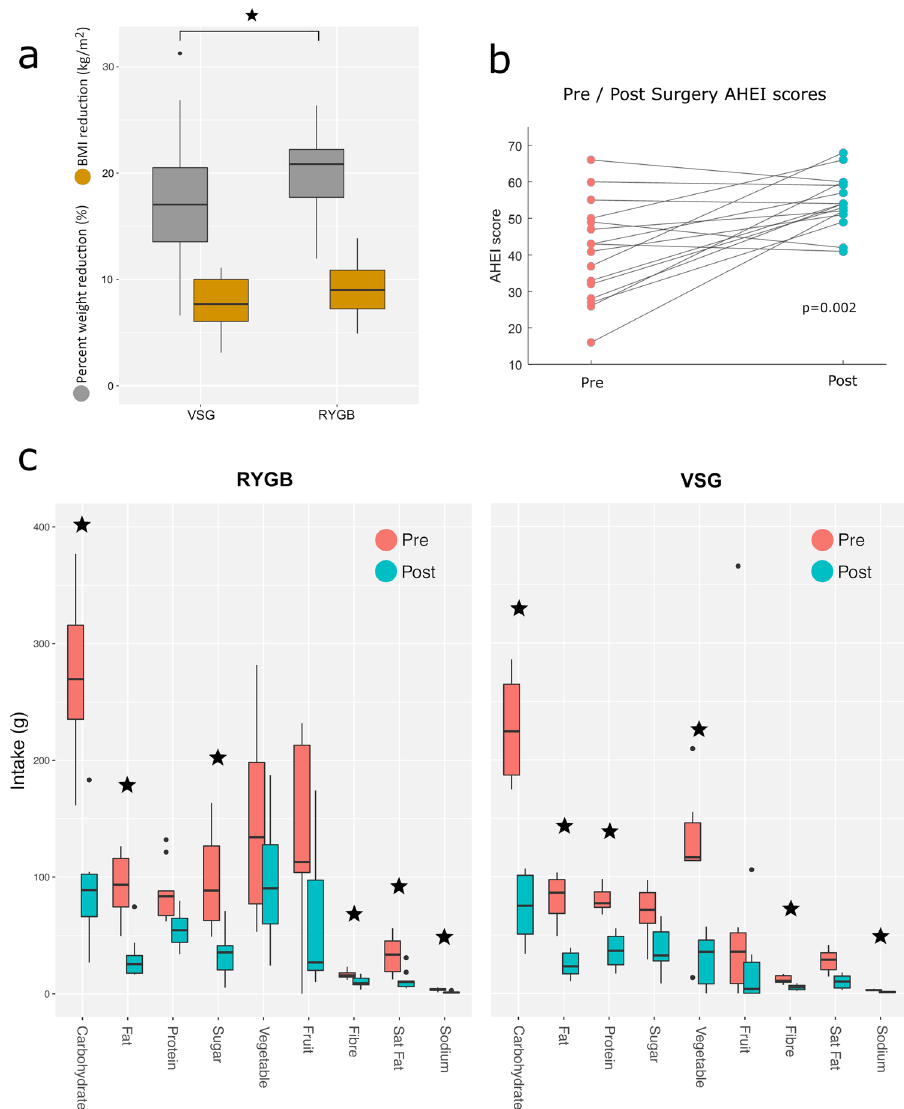
Fig. 4 Clinical fi ndings after bariatric surgery. a Box plots of weight-loss 3-months post Roux-en-Y Gastric Bypass (RYGB) ( n = 23) and Vertical Sleeve Gastrectomy (VSG) ( n = 26) procedures. Patients who underwent VSG had a mean (SD) weight-loss, percent weight-loss and body mass index (BMI) reduction of 21.7 kg (6.8), 17.3% (5.6) and 7.9 kg/m 2 (2.2), respectively. Patients who underwent RYGB had a mean (SD) weight-loss, percent weight-loss and BMI reduction of 24.6 kg (7.0), 20.2% (4.1) and 9.3 kg/m 2 (2.4), respectively. Percent weight-loss was signi fi cantly greater in the RYGB group ( p = 0.02). b Dietary healthiness measured by the Alternative Healthy Eating Index (AHEI) pre and 3-months post bariatric procedures. c Box plot of dietary intake pre and post RYGB & VSG procedures. Horizontal lines indicate the median, boxes indicate the interquartile range (IQR), whiskers extend to the upper adjacent value (Q3 + 1.5 x IQR) and lower adjacent value (Q1 – 1.5 x IQR), dots represent outliers. * p <